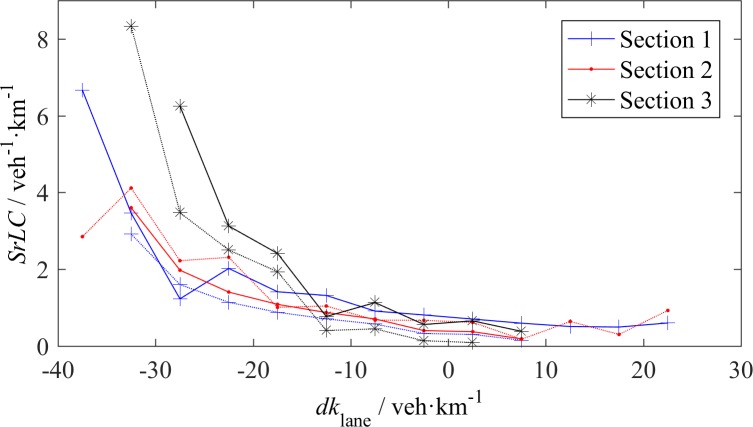
LC rate–density difference across the lanes (dklane) relationship, the solid lines represent SrLCL and the dashed lines represent SrLCR.